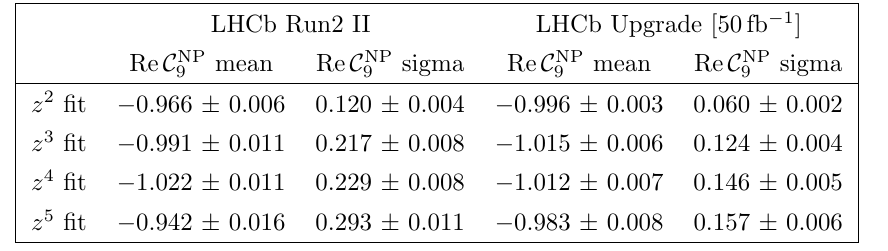
observable obtained from z 2 , z 3 , z 4 9